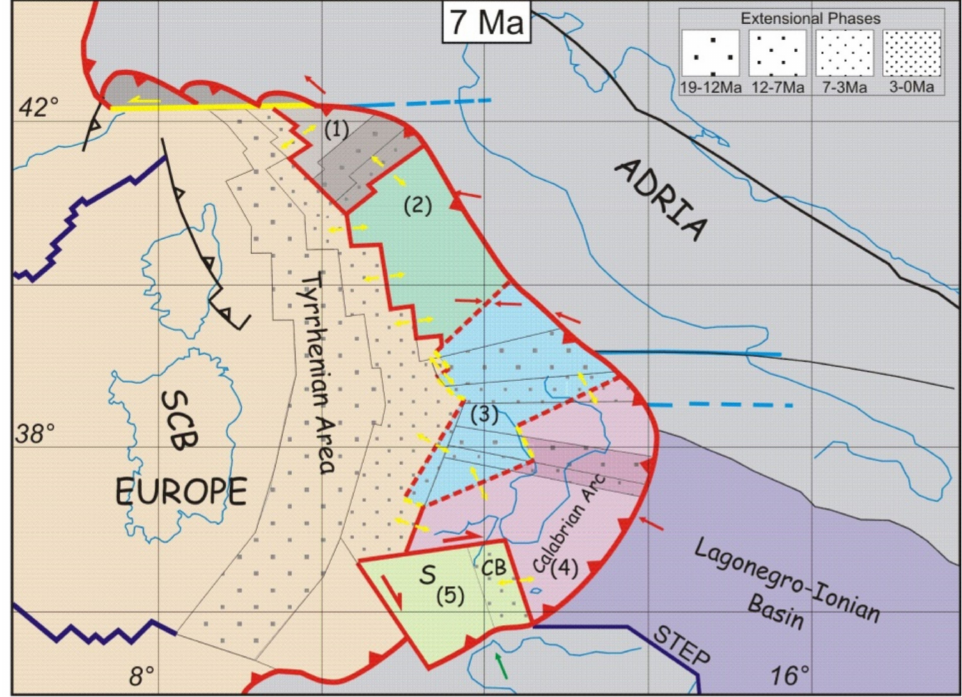
Figure 24. Plate reconstruction of the western Mediterranean region at 7 Ma. The Northern Sector ( 1 ) is shown in ( dark beige ); the Central Sector ( 2 ) is in ( green ); the Southern Sector ( 3 ) is in ( light blue ); the Calabrian Arc Sector ( 4 ) is in ( pink ), the Sicilian Sector in ( light green ) ( 5 ). ( Dotted areas ) are in extension (see upper right legend). ( Dotted lines ) are incipient boundaries. ( Red lines ) are active boundaries. ( Black lines ) are inactive boundaries. ( Yellow lines ) are strike-slip faults. ( Light blue lines ) are transfer faults on the continental lithosphere. ( Dark blue lines ) are the Middle-Triassic COB. ( Red arrows ) are the velocity vectors between Adria and the adjacent sector. CB, Caltanissetta Basin; S: Sicily, SCB: Sardinian-Corsican